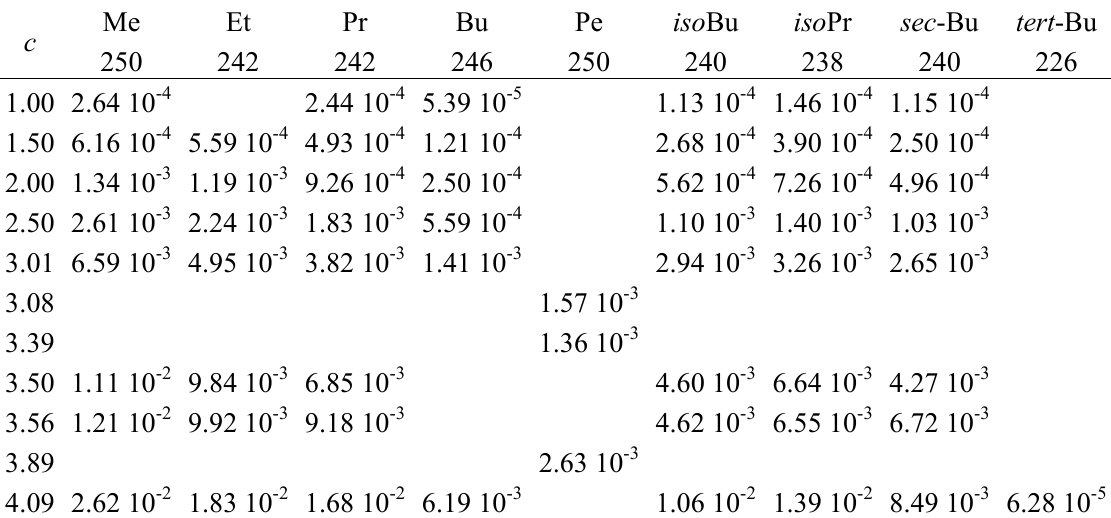
(s –1 ) of the first kinetically measurable Table II Values of observed rate constants k obs step of acid-catalysed hydration of α -alkylstyrenes depending on sulphuric acid concentration c (mol·dm –3 ) in water at 25 °C; the values in the second line